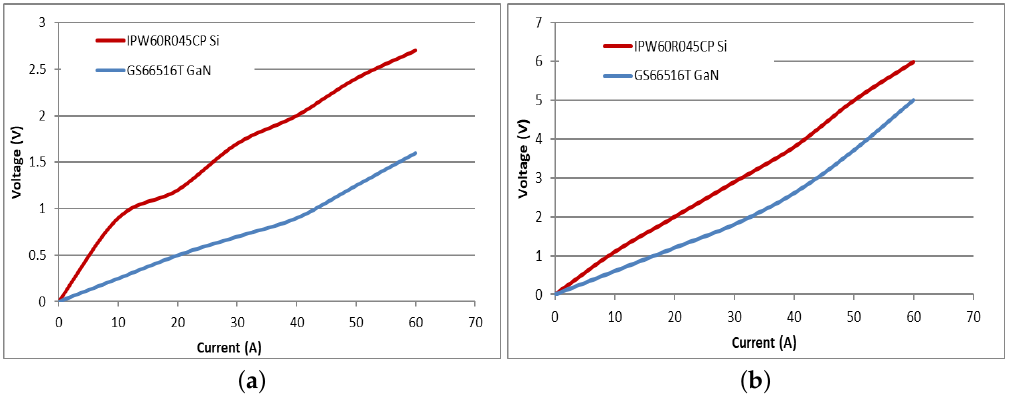
Figure 5. Forward voltages of Si MOSFET and GaN HEMT at various current and junction temperature: ( a ) Si MOSFET and GaN HEMT forward voltage at 25 ◦ C junction temperature; ( b ) Si MOSFET and GaN HEMT forward voltage at 150 ◦ C junction temperature.